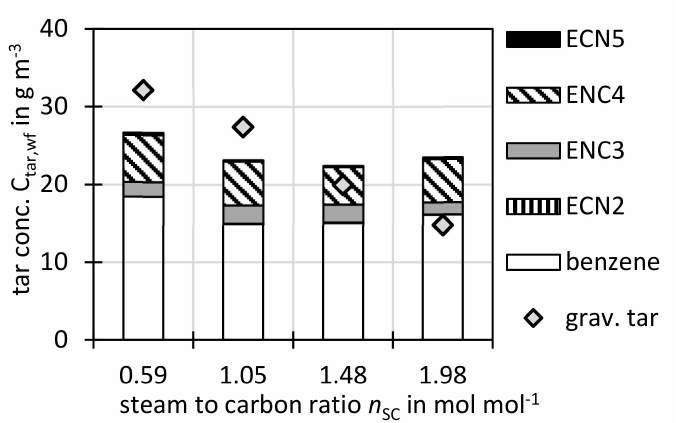
Figure 8. Gravimetric and GC tar concentrations on dry, N 2 -free and STP basis at different steam to carbon ratios n SC